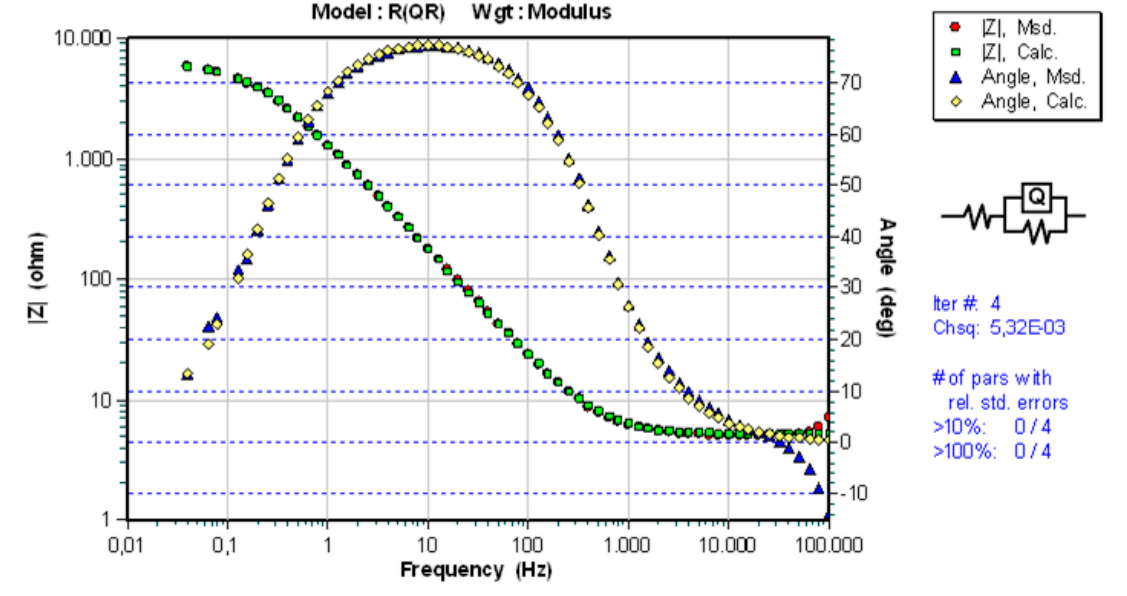
Figure 10. Bode plot of WC-11 Co-c.